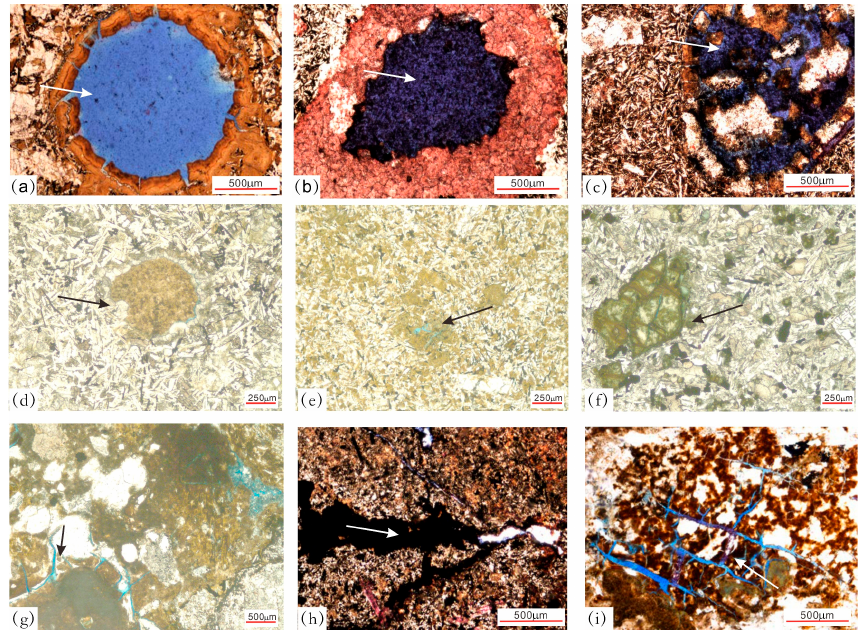
Figure 3. Lithological characteristics and pore characteristics of the Zao35 fault block. ( a ) pore; ( b ) almond; ( c ) almond internal pore; ( d ) almond internal pore; ( e ) interstitial structure; ( f ) macular structure; ( g ) intergranular microcracks; ( h ) structural joint; ( i ) diagenetic contraction joint.